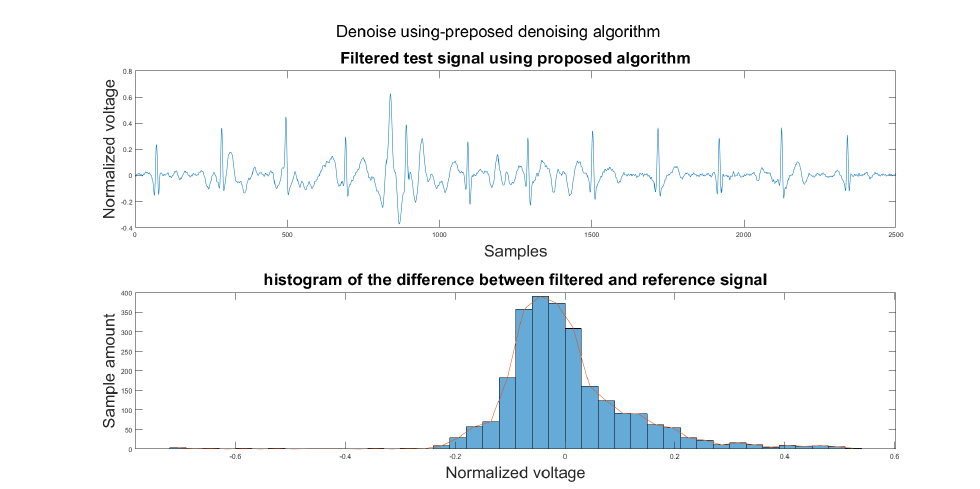
Figure A7. (1) Test signal, (2) histogram of the difference.